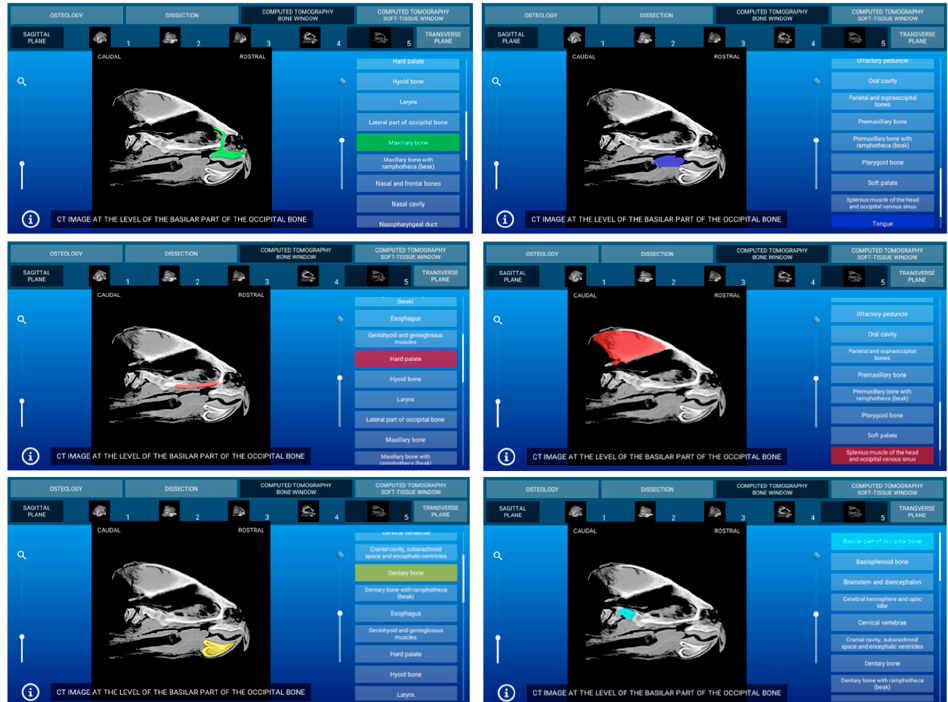
Figure 6. Atlas dissections section: an interactive image of the central nervous system is shown in dorsal aspect.